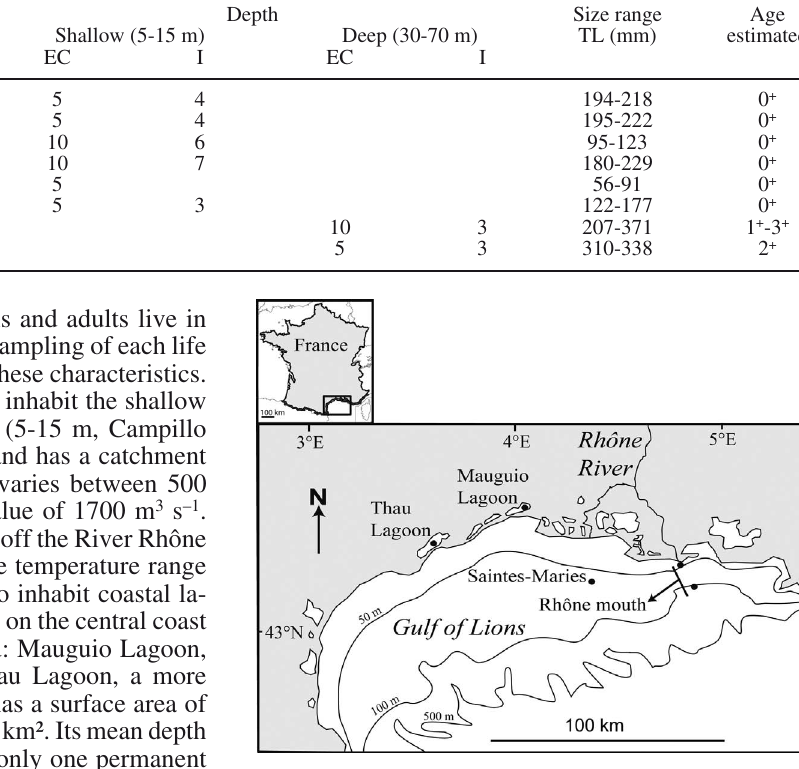
Fig . 1. – Location of study sites in the northwestern Mediterranean Sea. All sites were used for otolith trace elemental analyses and for determination of the stable isotopic signatures of